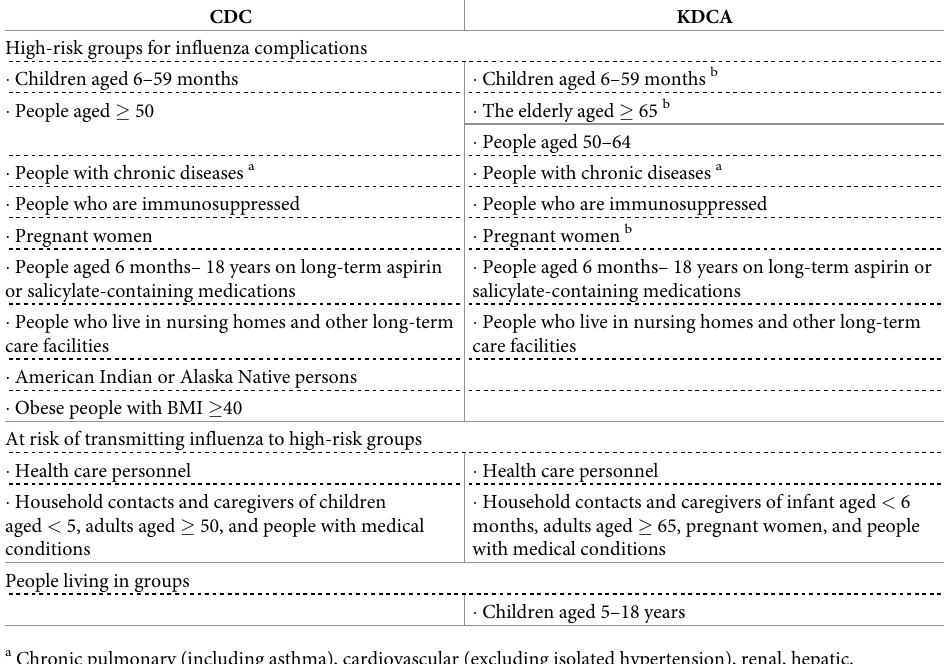
Table 1. The prioritized groups for influenza vaccine designated by CDC and